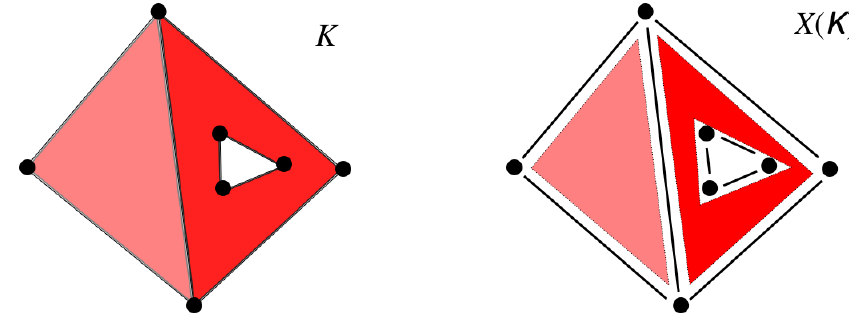
Figure 1. A topologically consistent configuration given as a partitioned space K ( left ) and its face poset X ( K ) ( right